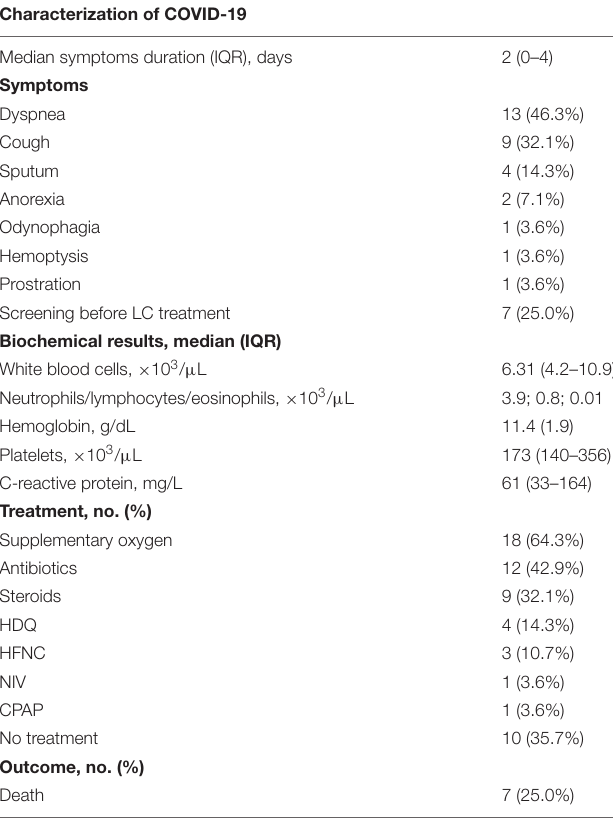
TABLE 2 | Characterization of symptoms, management, and outcomes of COVID-19 in LC patients. Characterization of